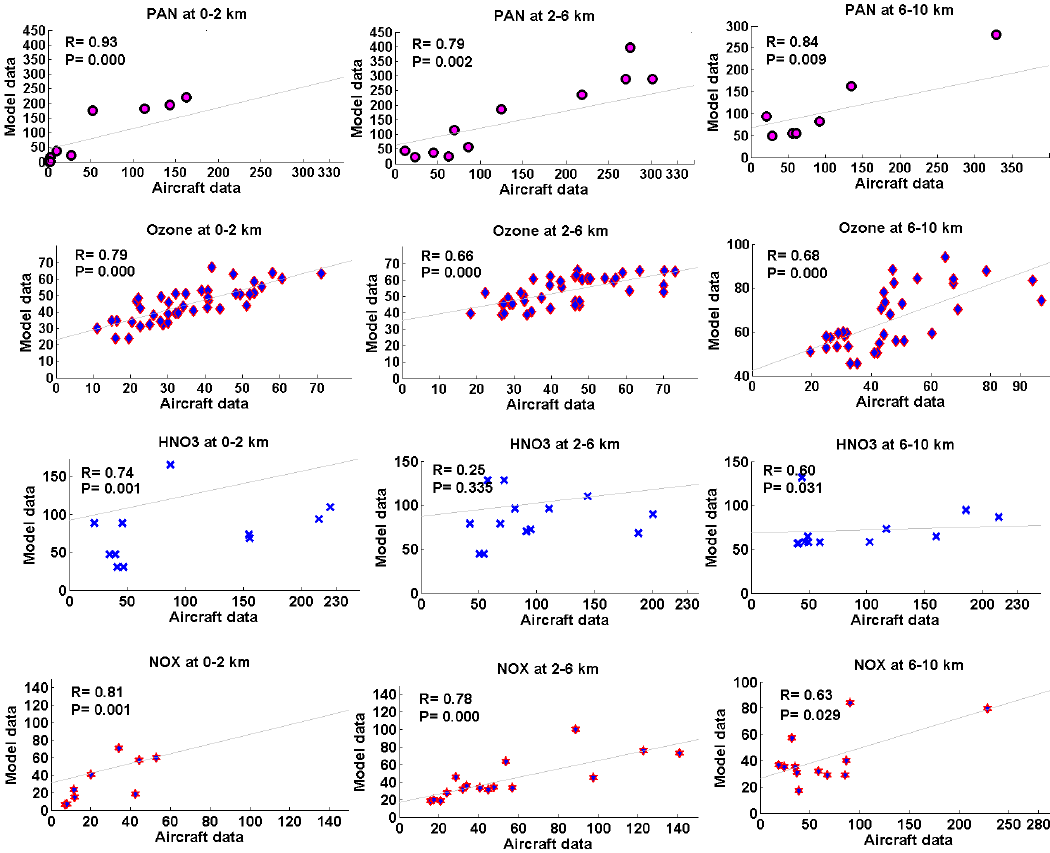
Figure 2. Scatter plot between model simulation (averaged for for 1995–2004) and aircraft observations of PAN (ppt), ozone (ppb), HNO 3 (ppt) and NO x (ppt) (averaged for the monsoon season (June–September) ). The model simulations and aircraft observations are averaged for altitude ranges over the coherent regions. The Pearson’s correlation coefficient ( R ) and corresponding p-value is given in each